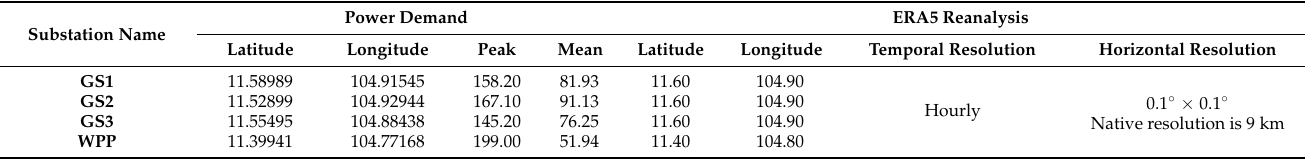
Table 1. Power demand information of the substations considered in this study and the nearest grid point information of ECMWF-ERA5 reanalysis with spatial and temporal